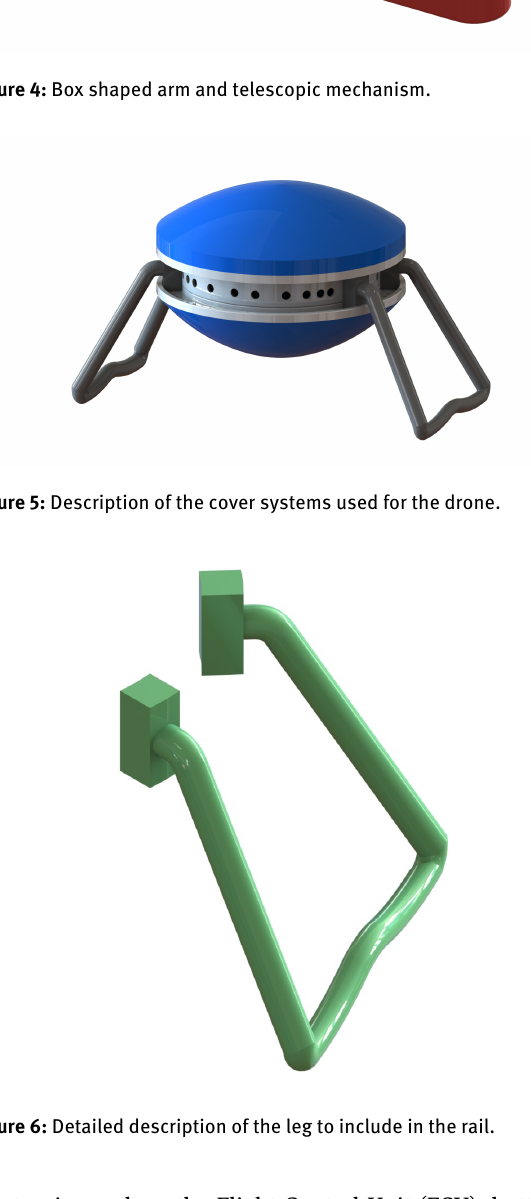
Figure 3: Assembling procedure for the different drone components.